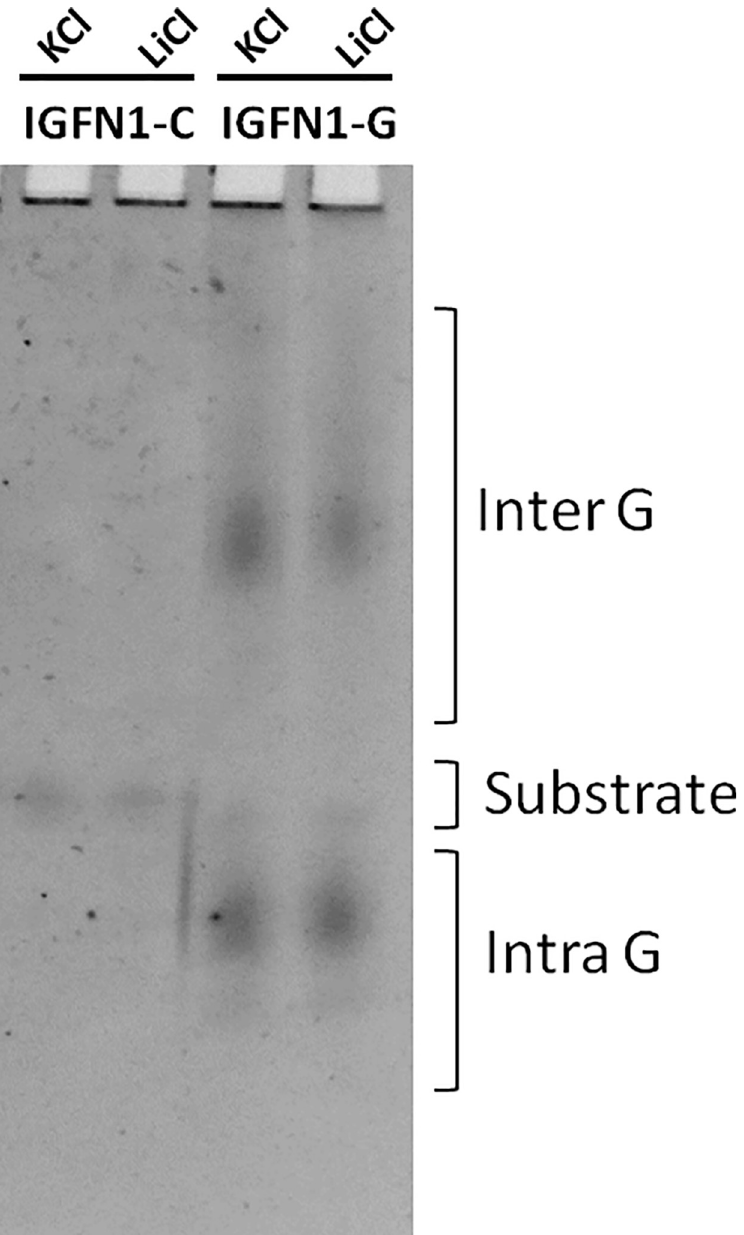
Fig 3. Gel shift assay by native PAGE. IGFN1-G and IGFN1-C incubated with 100 mM LiCl and KCl and resolved on 15% native PAGE, intra and intermolecular G-quadruplex structures are mentioned.